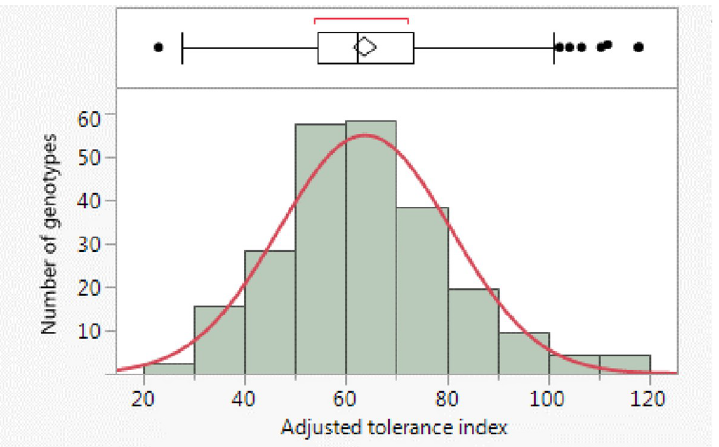
Fig 1. Distribution of adjusted tolerance index among the 234 soybean